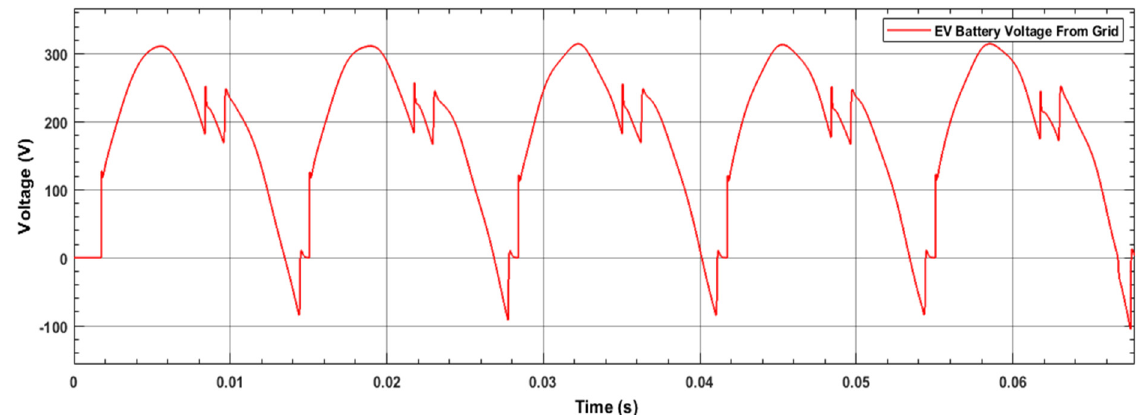
Figure 11. Electrical vehicle battery voltage from grid.